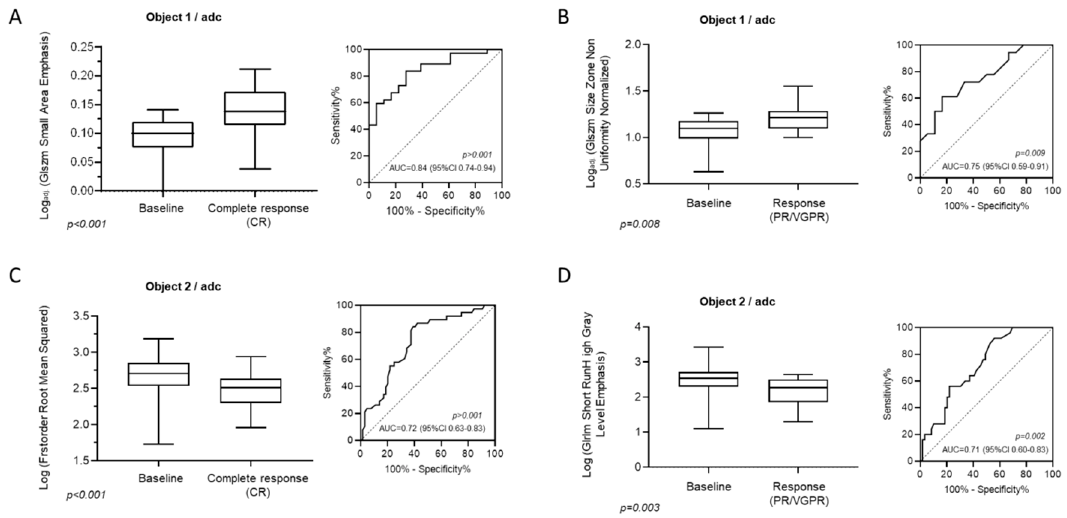
Figure 3. Box plots on the left presenting the statistically significant textural features on ADC images both in focal ( A/B ) and diffuse marrow involvement ( C/D ) both for patients experiencing complete response ( A/C ) and very good partial response/partial response( B/D ). The receiver-operator characteristic (ROC) analysis on the right illustrates the area under the curve (AUC), corresponding p -value and confidence interval for the log of the analyzed texture feature. GLRLM = gray-level run-length matrix.